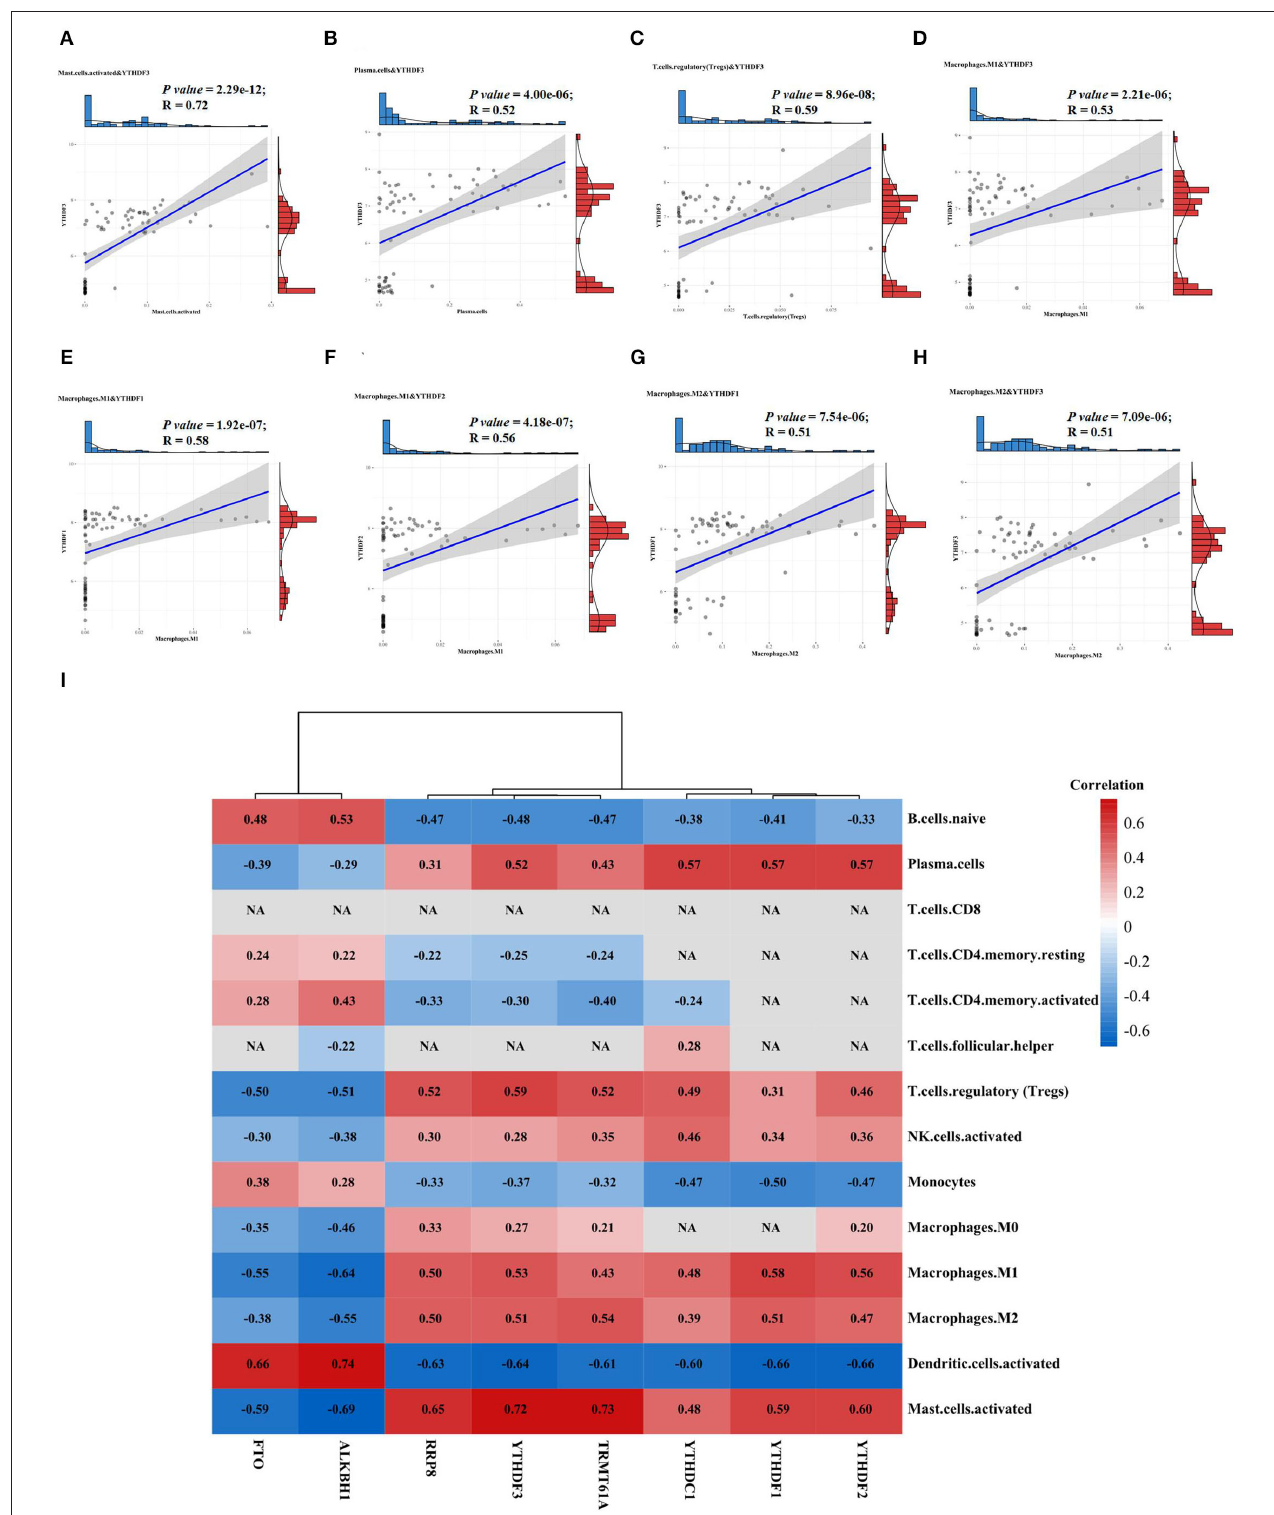
FIGURE 4 | The relationships between DEMRGs and immune cells. (A) Scatter plot of the correlation between YTHDF3 and activated mast cells; (B) Scatter plot of the correlation between YTHDF3 and plasma cells; (C) Scatter plot of the correlation between YTHDF3 and regulatory T cells (Tregs); (D) Scatter plot of the